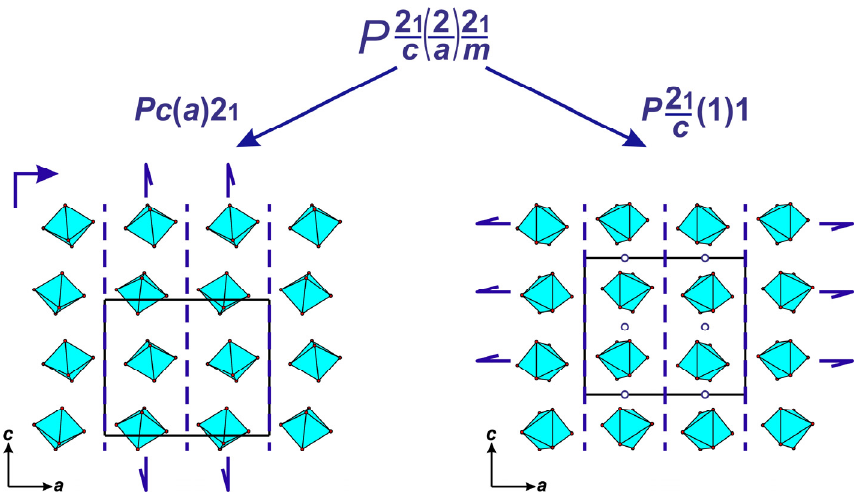
Figure 2. Different symmetry operators that may be active in the L 2 n type layer: the 2 1 screw axis parallel to c [– – 2 1 ] (left) and inversion centers and the 2 1 screw axis parallel to a [2 1 – –] (right). In accordance with the NFZ relation [27,28], there is only one kind of the ( L 2 n , L 2 n +1 , L 2 n +2 ) triples and two kinds of the ( L 2 n -1 , L 2 n , L 2 n +1 ) triples. Consequently, the smallest possible number of different triples in a structure is two and only two MDO